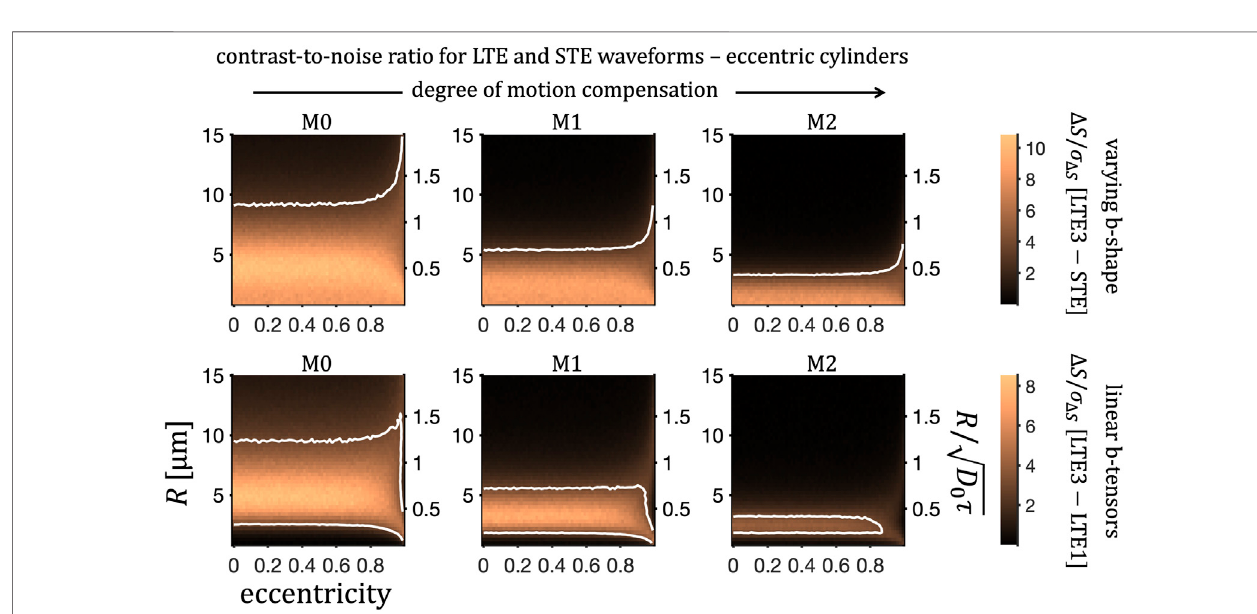
FIGURE12| SizesensitivityforeccentriccylindricalporesatSNR=25.Contrast-to-noiseratio, Δ S / σ Δ S at b =2 ms/ μ m 2 andfor f R =0.5isshownforM0-,M1-,and (cid:6)(cid:6)(cid:6)(cid:6)(cid:6)(cid:6)(cid:6)(cid:6)(cid:6)(cid:6)(cid:6) (cid:11) M2- (left to right) LTE and STE waveforms as a function of mean radius R and eccentricity ϵ . For ellipsoidal cross-section with semi-axes R 1 and R 2 < R 1 , we have (cid:10) (cid:6)(cid:6)(cid:6)(cid:6)(cid:6) ϵ (cid:2) , so that R 2 , 1 (cid:2) R ( 1 − ϵ 2 ) ±1/4 . Two common colour scales are used to show contrast-to-noise ratios for rotation-averaged 1 − ( R 2 / R 1 ) 2 and de fi ne R ≡ R 1 R 2 signals from LTE3 and STE (top row) and from LTE1 and LTE3 (bottom row). Contour lines indicate Δ S / σ Δ S = 3. For comparison with Figures 11 , 13 , were 15 rotations were used in directional averaging instead of 60 required for asymmetric pores, the SNR was here rescaled according to SNR 60 (cid:2) SNR 15